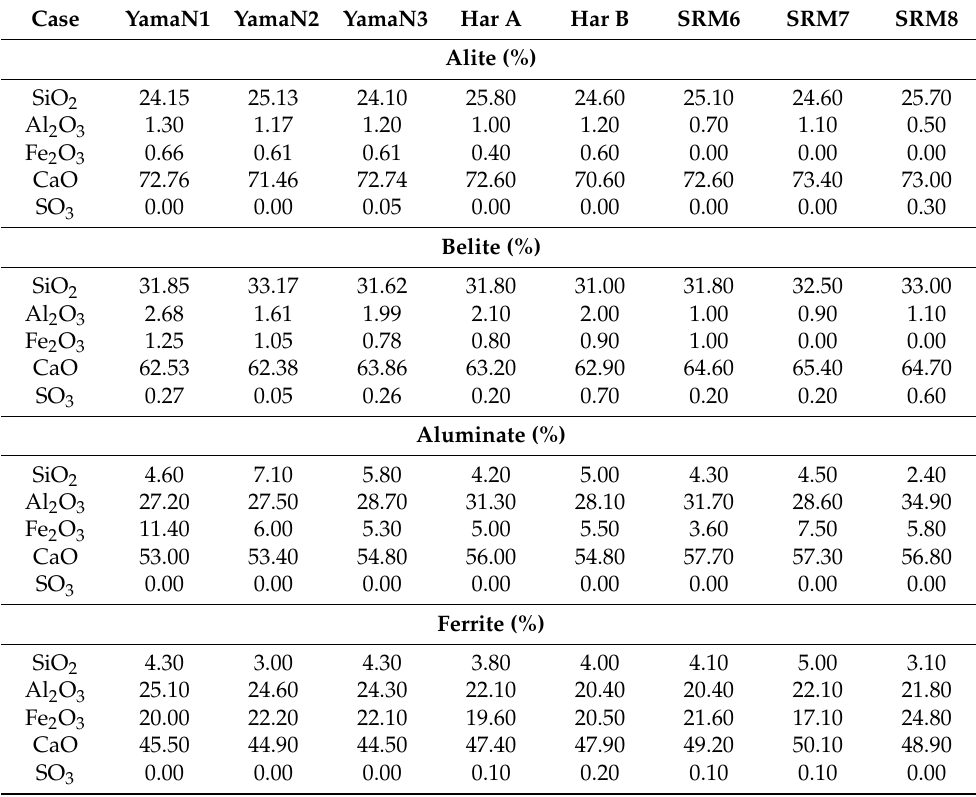
Table 7. Chemical compositions of the cement compounds reported by Stutzman